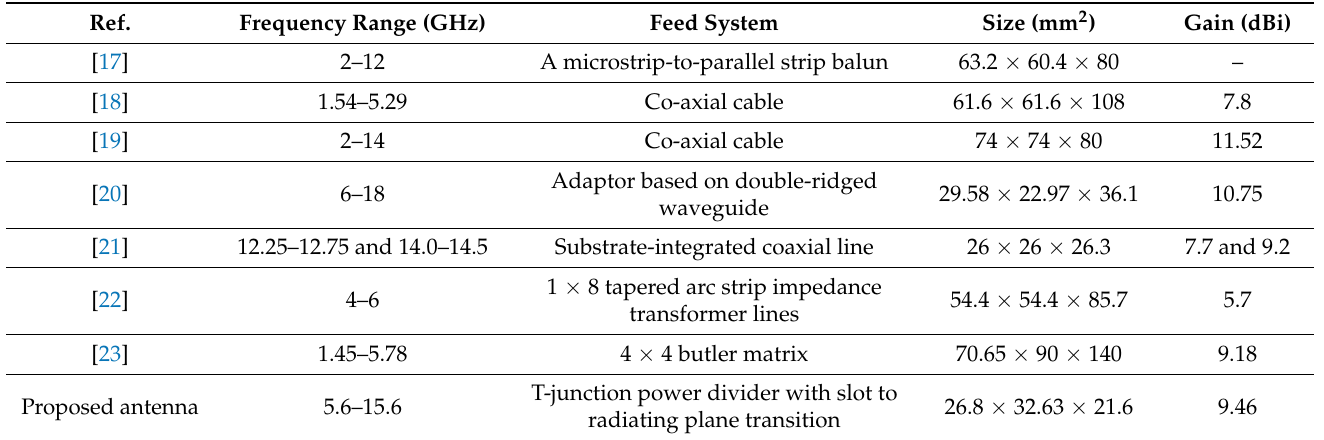
Table 2. Comparison table based on antenna bandwidth, feed system, size, and